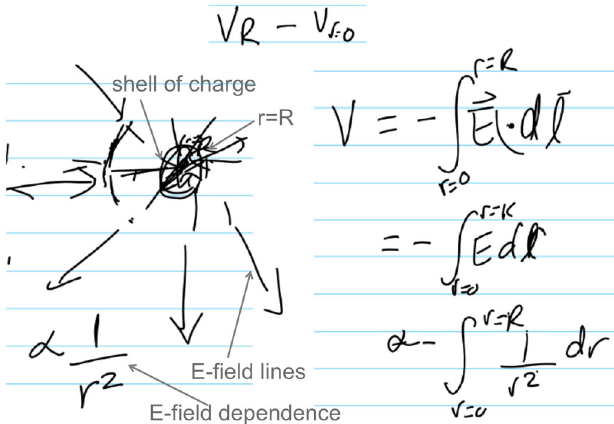
FIG. 6 (color online). Student drawing from interview ques- tion about potential. The student’s sketch is to the left and her calculations to the right. She originally drew the charged shell as hollow, and explicitly mentioned that E ¼ 0 there. The scribbles visible in the shell are part of a later